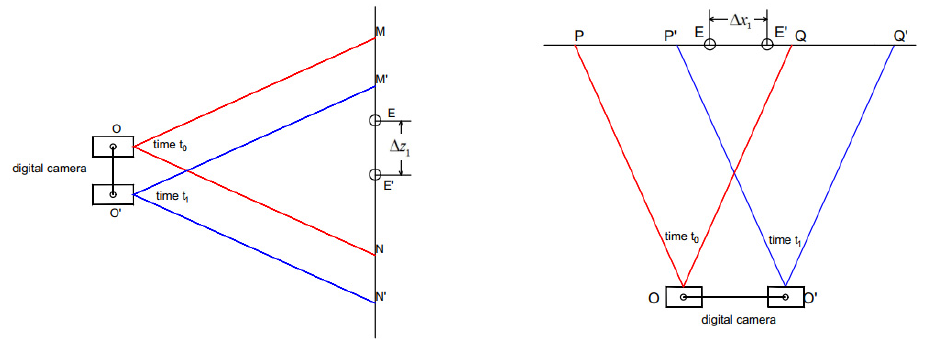
Figure 7. Calculation principle of ∆ x 1 , ∆ z 1 . The red line represents the shooting Angle before the digital camera and the landmark are moved. The blue line represents the shooting Angle after the digital camera and the mark point are moved.